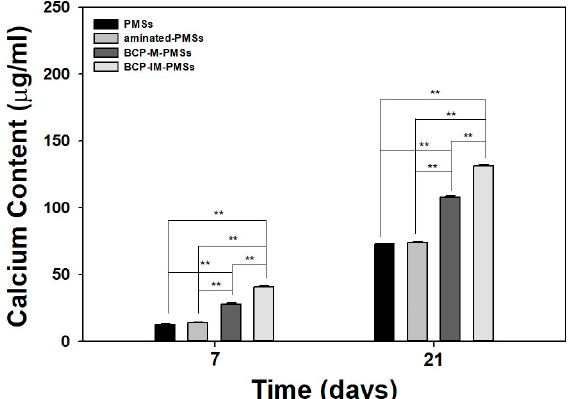
Figure 5. Amount of calcium deposited by MG-63 cells grown on PMSs, aminated-PMSs, BCP-M-PMSs, or BCP-IM-PMSs after 7, 14, or 21 days of incubation ( n = 5) (* p < 0.05 and ** p < 0.01).